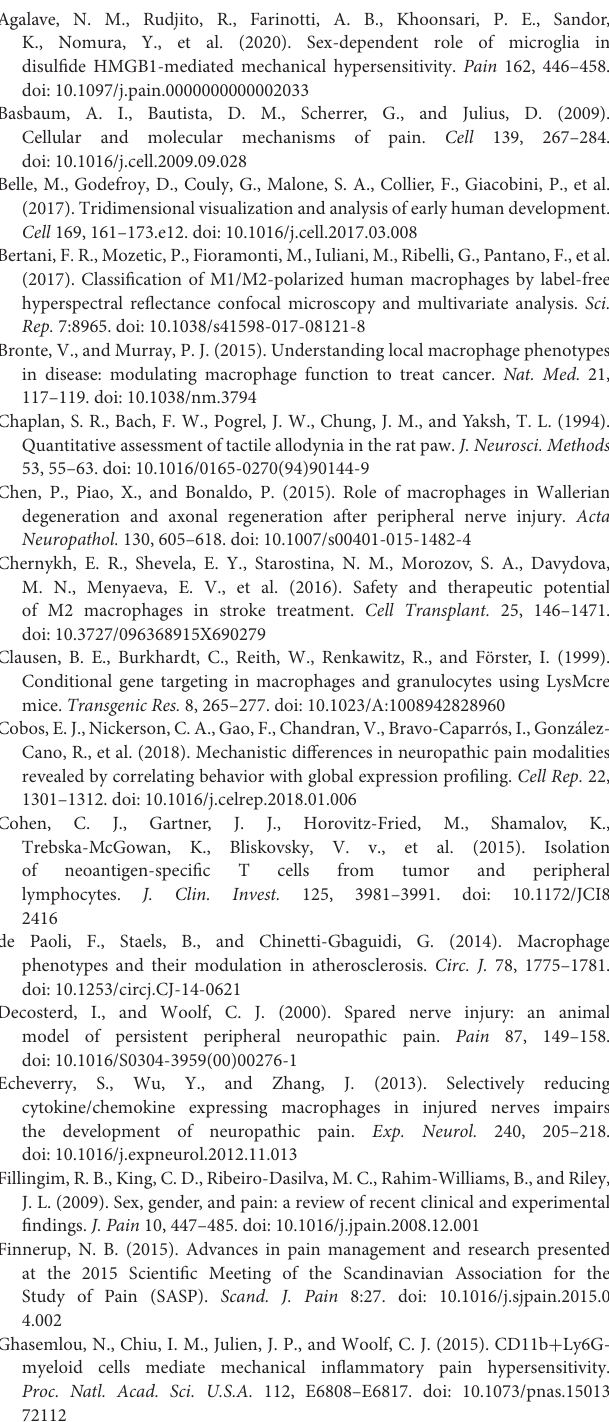
Supplementary Figure 7 | 3-Dimensional video render of a cleared Female SNI Ipsilateral DRG. Visualized cells are LysM tdT + macrophages infiltrating into the tissue.